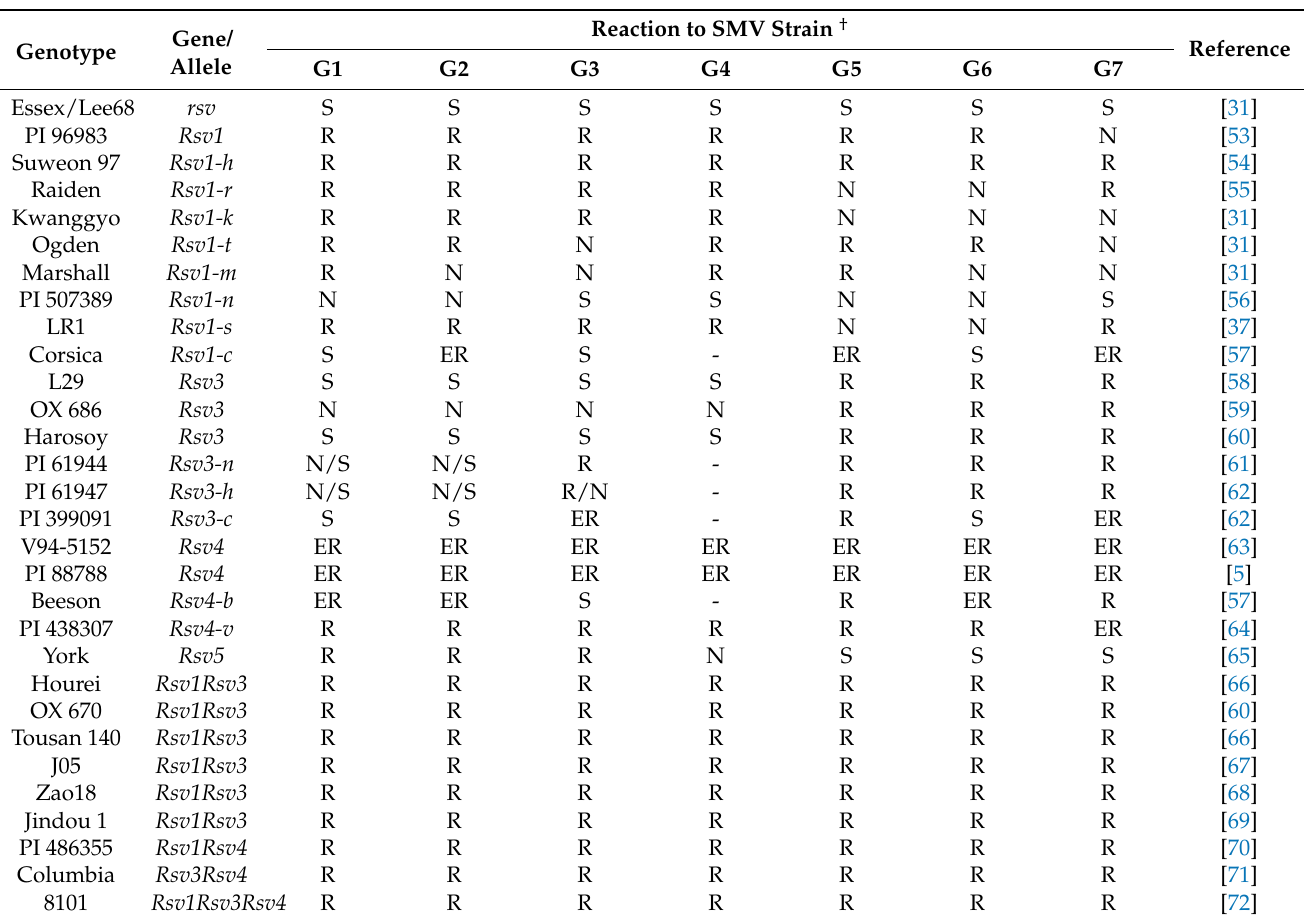
Table 1. Differential reactions of soybean genotypes to Soybean mosaic virus SMV strains in the